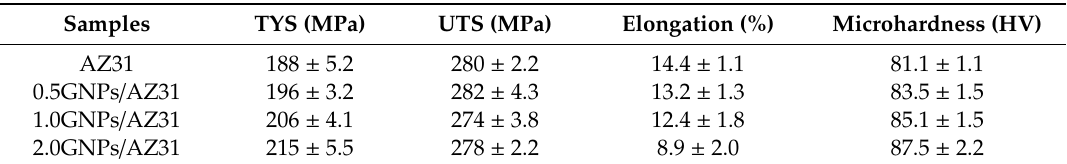
Figure 6. Effect of the content of GNPs on: ( a ) microhardness, and (b ) the tensile properties. Table 4. Mechanical properties of AZ31 alloy and the GNPs / AZ31 composites.